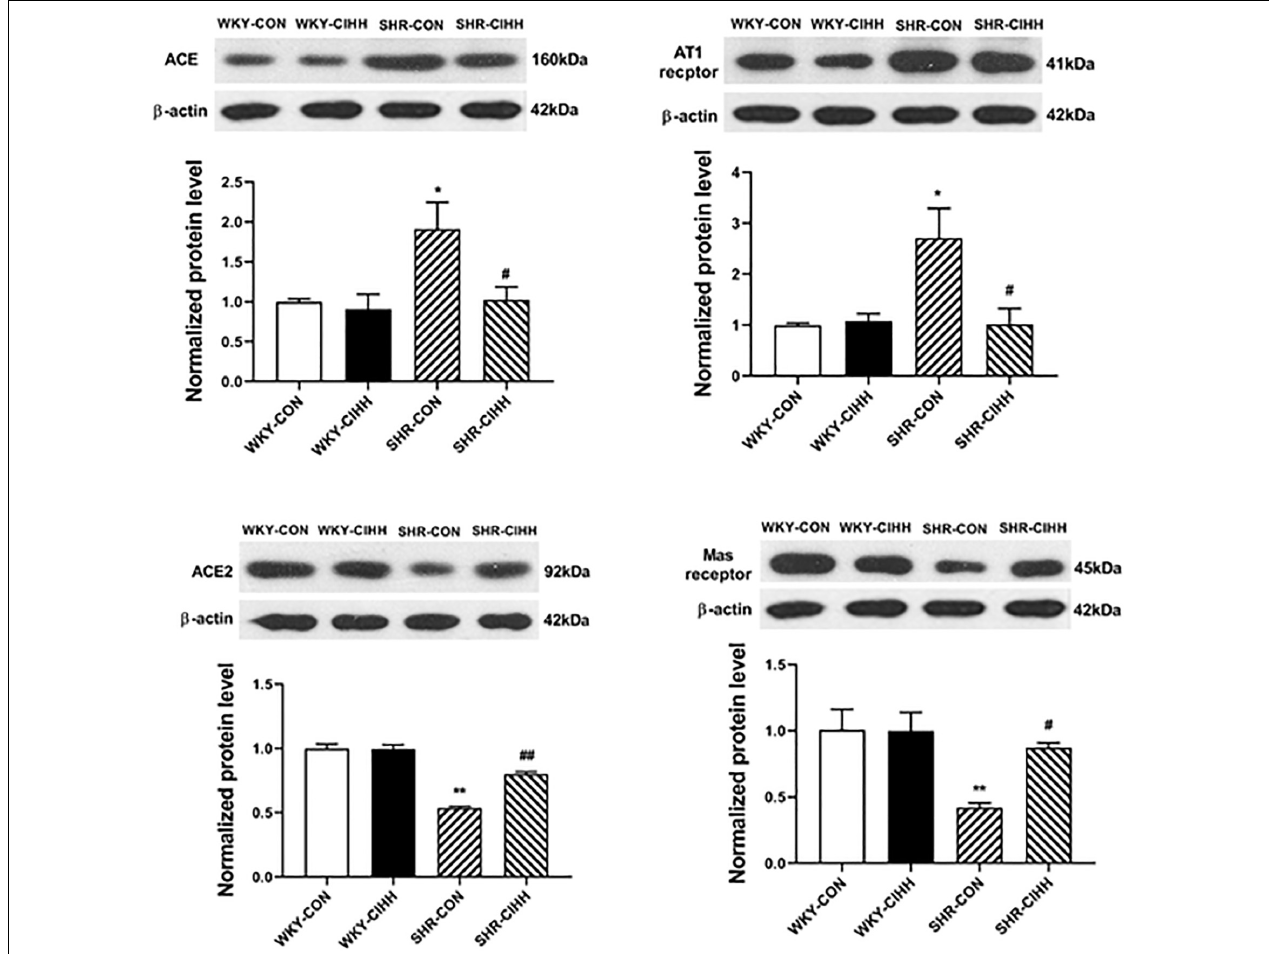
FIGURE 9 | Effect of chronic intermittent hypobaric hypoxia (CIHH) on the expression of ACE, ACE2, AT1, and Mas in the mesenteric arteries of spontaneously hypertensive rats (SHRs). Data are expressed as mean ± SEM; n = 6 for each group. SHR-CON: control SHR; SHR-CIHH: SHR with CIHH; WKY-CON: control WKY rats; WKY-CIHH: WKY rats with CIHH; * P < 0.05, ** P < 0.01 vs. WKY-CON, # P < 0.05, ## P < 0.01 vs. SHR-CON (one-way